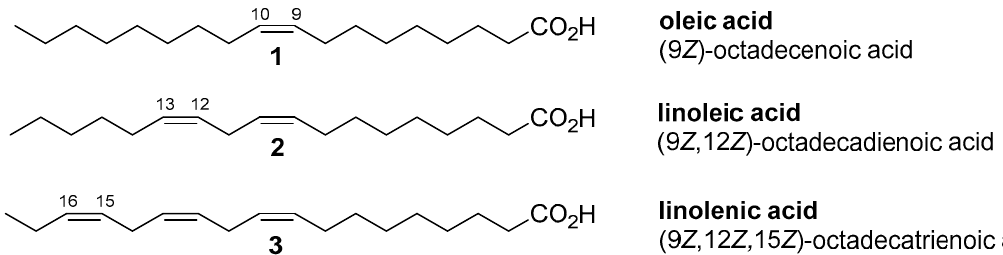
Figure 1. The most common C 18 unsaturated fatty acids: oleic ( 1 ), linoleic ( 2 ), and linolenic ( 3 ) acid. These fatty acids share in common the presence of a cis double bond between C(9) and C(10)